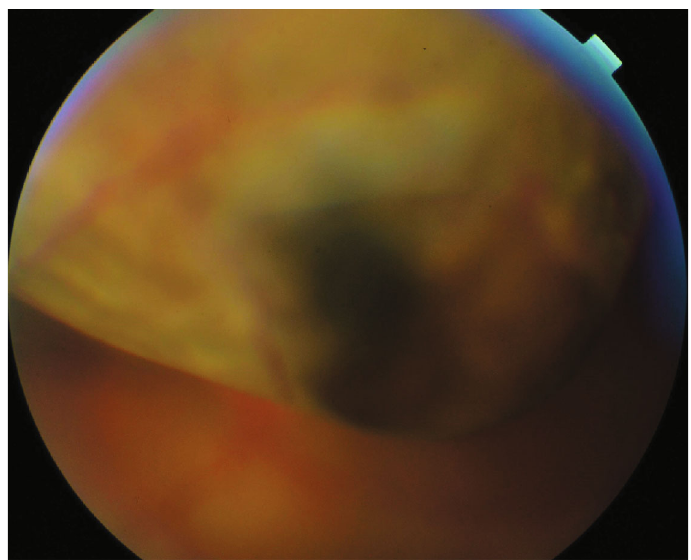
Figure 1: Deeply pigmented choroidal lesion with a retinal